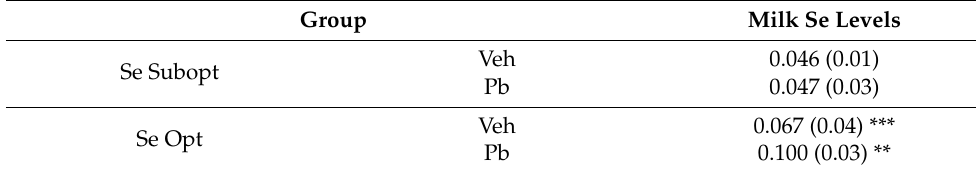
Table 2. Se concentrations in early maternal milk ( µ g Se/mL): medians and IQRs. Group Milk Se Levels